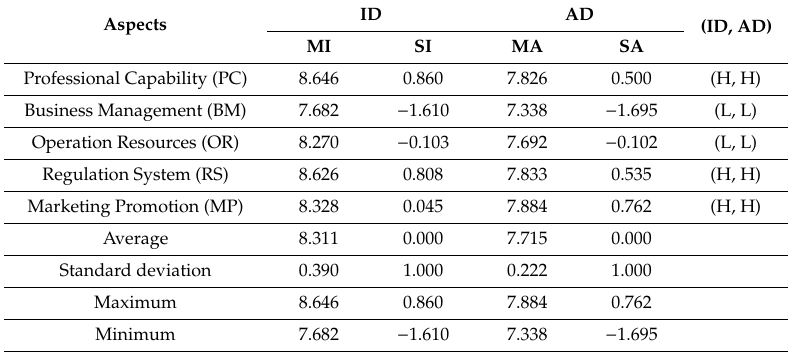
Table 3. The Importance Accessibility Analysis (IAA) for industrial